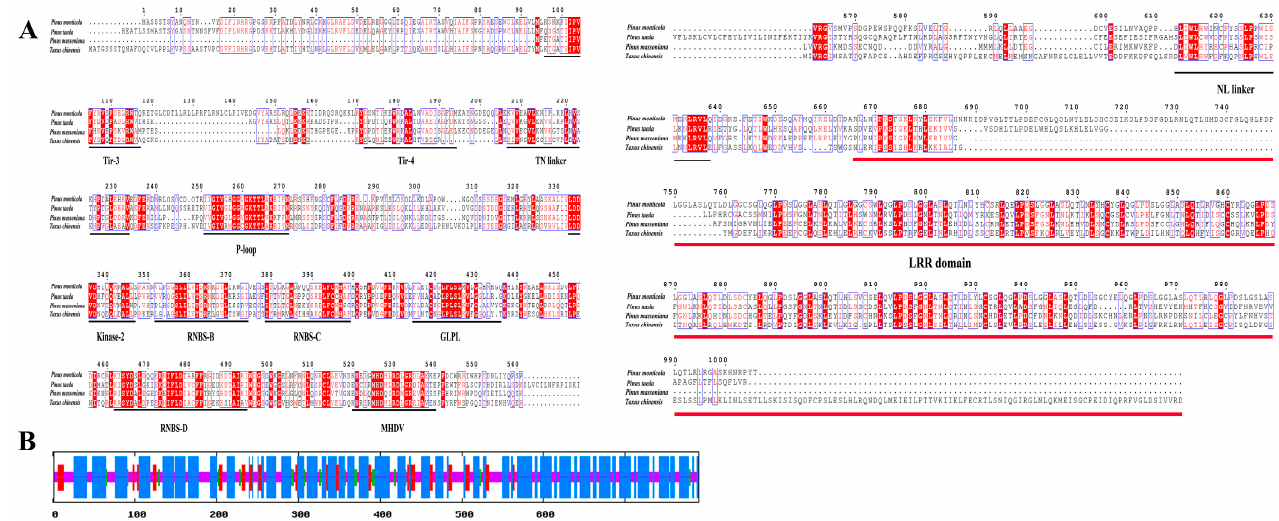
Figure 3. Sequence and protein structure analysis of PmNBS-LRR97 of P. massoniana . ( A ) Analysis of the conserved domains and conserved motifs of TNL homologous genes in P. massoniana , P. monticola , P. taeda , and Taxus chinensis . ( B ) Prediction of the secondary structure of the PmNBS-LRR97 . Blue, red, green, and orange represent alpha helix, extended strand, beta turn, and random coil, respectively.